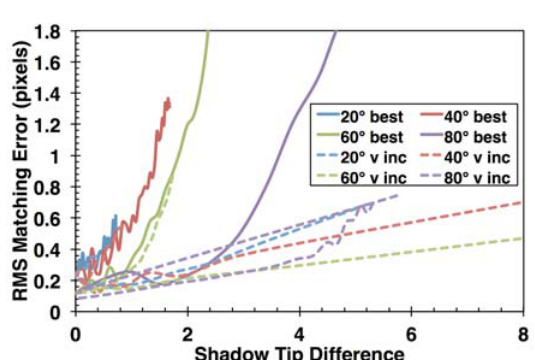
Figure 7. DTM precision for stereopairs with mismatched sun azimuth (solid curves) or incidence angle (dashed curves). The legend indicates the incidence angle of the left image, which is illuminated from the east in all cases. Results are plotted as a function of shadow tip distance STD (see text). Dashed curves extending to the right correspond to pairs in which the right image has a higher incidence angle than the left. In general, DTM quality is more forgiving of incidence angle increases than of decreases or azimuth differences.